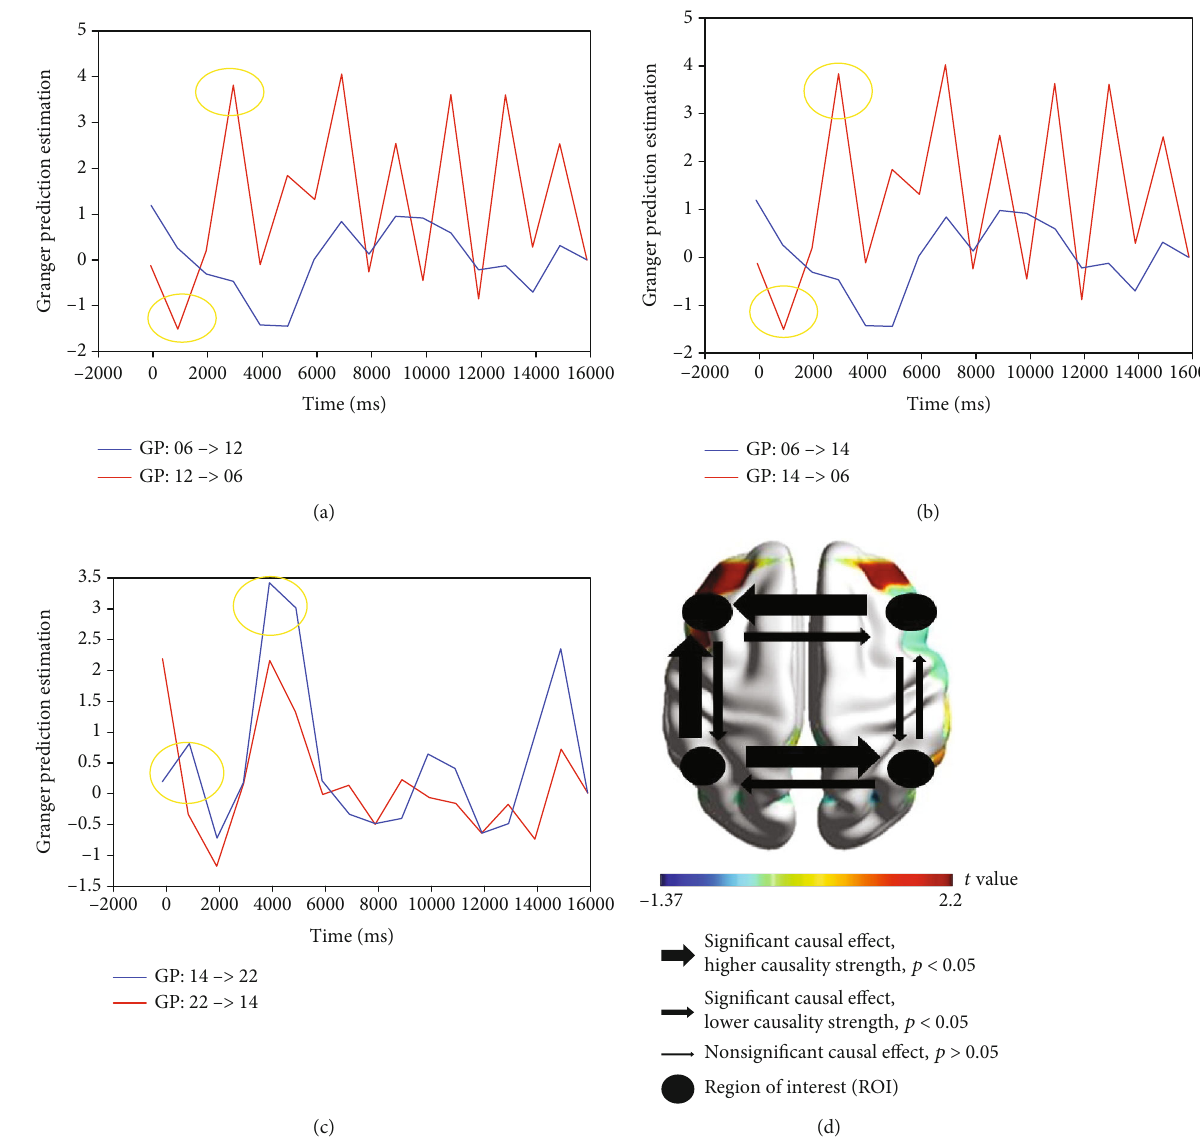
Figure 6: Granger Prediction Estimation generated directional relations measured from HBO2 measurements among signi fi cant ROIs in meaningless condition: (a) right Broca/Ch12 to left Broca/CH06 ( p < 0 : 005 ); (b) left Wernicke/Ch14 to left Broca/Ch6 ( p < 0 : 010 ); (c) left Wernicke/Ch14 to right Wernicke/Ch22 ( p < 0 : 021 ). The fi rst yellow circle represents the onset of the fi rst trial over 500ms, and the second one represents stimulus period presentation of the fi rst trial over 2200-2700ms integrating the semantic judgment; (d) causality strength across ROI ( p < 0 : 05 ) in the meaningless condition during the experimental